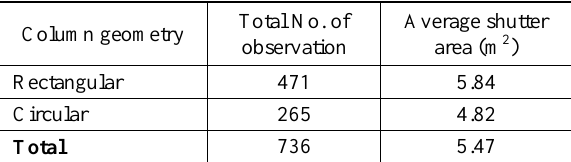
Table 6. Average shutter areas of rectangular and